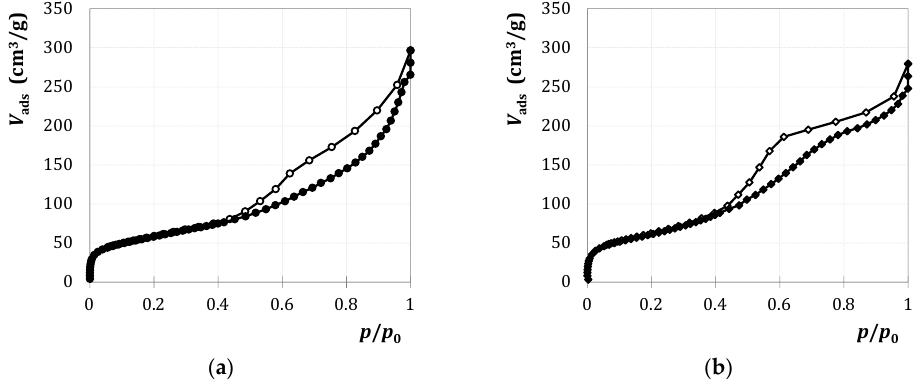
Figure 7. Nitrogen adsorption and desorption at 77 K on ( a ) M2(0)/SiO 2 90:10 and ( b ) M2(12)/SiO 2 90:10.